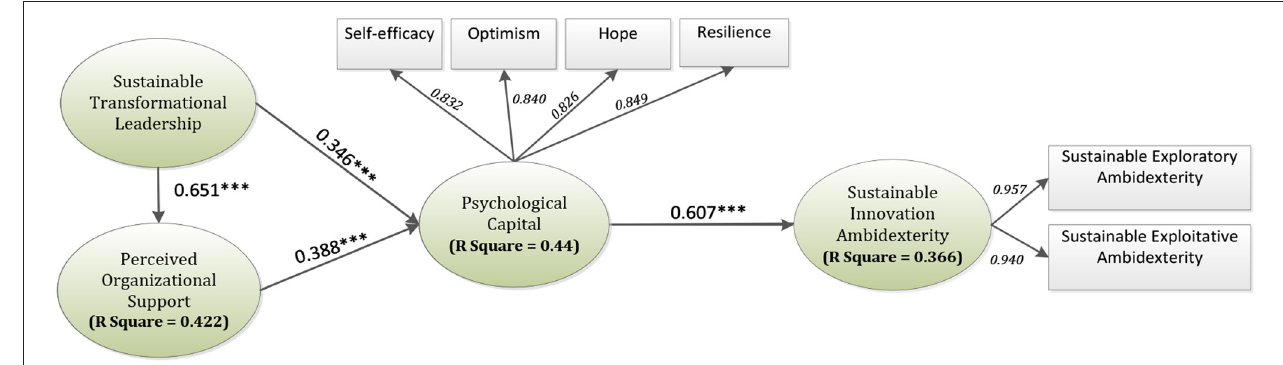
FIGURE 2 | Results of the inner model. *** p -value